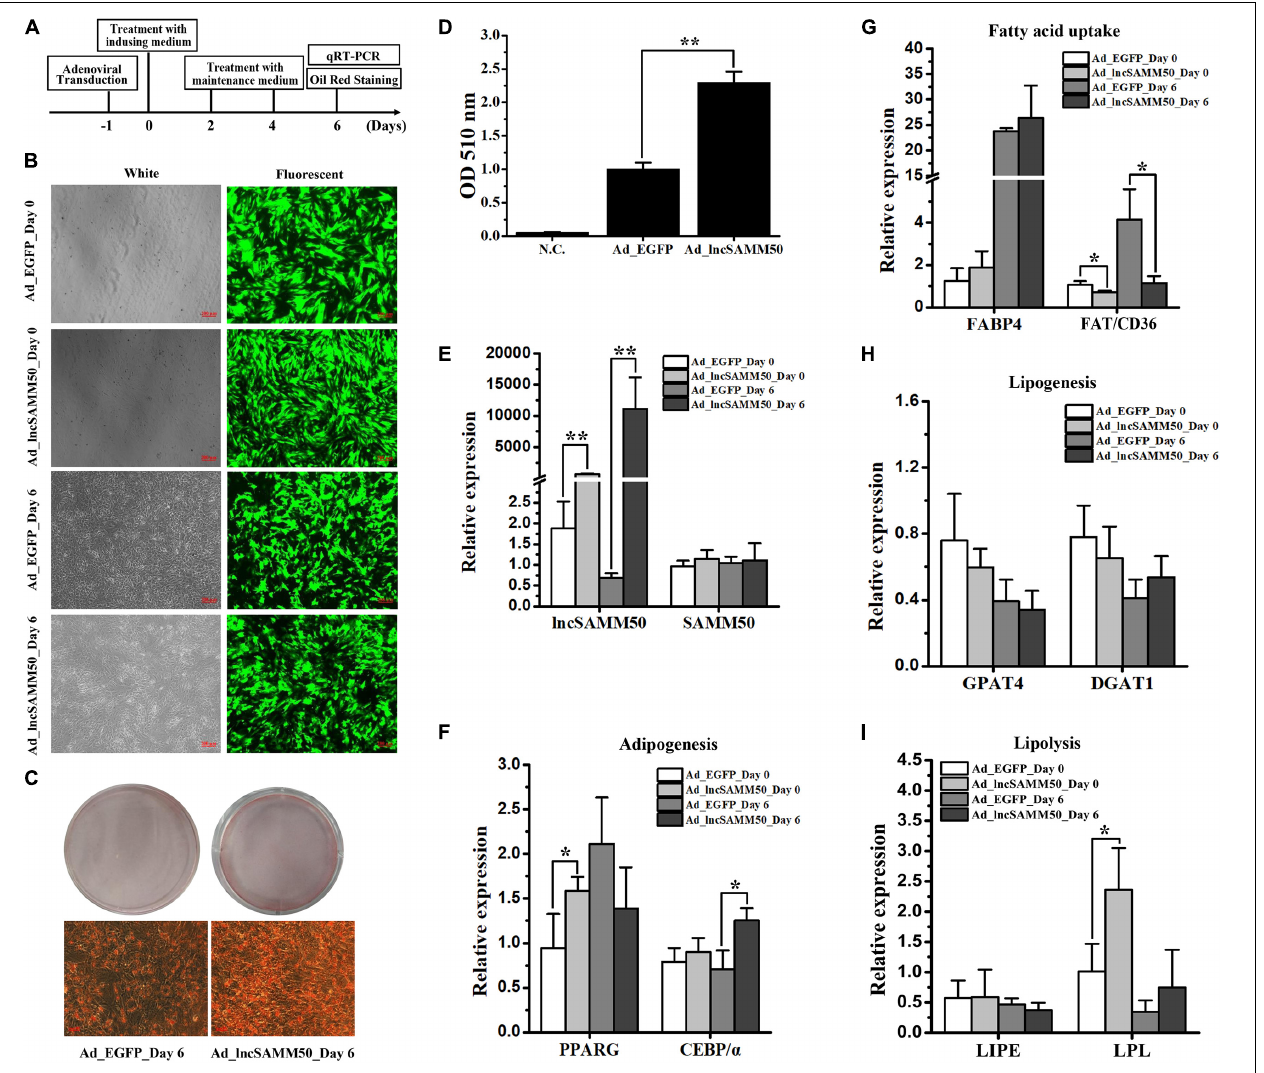
FIGURE 5 | Overexpression of lncSAMM50 enhances adipogenic differentiation of buffalo adipocytes. (A) Strategy of lncSAMM50 overexpression, adipogenic differentiation, and Oil Red O staining in buffalo adipocytes. (B) Micrographs of EGFP-positive cells in the ad_EGFP (control) and ad_lncSAMM50 groups on day 0 and day 6 of adipogenic differentiation. Scale bar, 200 µ m. (C) Images of Oil Red O staining in buffalo adipocytes transduced with ad_EGFP and ad_lncSAMM50 on day 6 of adipogenic differentiation. Scale bar, 50 µ m. (D) Histogram showing the quantitation of Oil Red O staining by spectrophotometry. NC, negative control. (E–I) The RNA expression levels of lncSAMM50, SAMM50, PPARG, C/EBP α , FABP4, FAT/CD36, GPAT4, DGAT1, LIPE, and LPL on day 0 and day 6 of adipogenic differentiation in buffalo adipocytes transduced with ad_EGFP and ad_lncSAMM50. GAPDH was used to normalize the expression level of the candidate gene in buffalo adipocytes. The cycle threshold (2 − (cid:49)(cid:49) Ct ) method was used to calculate the relative expression level of the candidate gene. Data are presented as the mean ± SD ( n = 3; * p < 0.05; ** p <